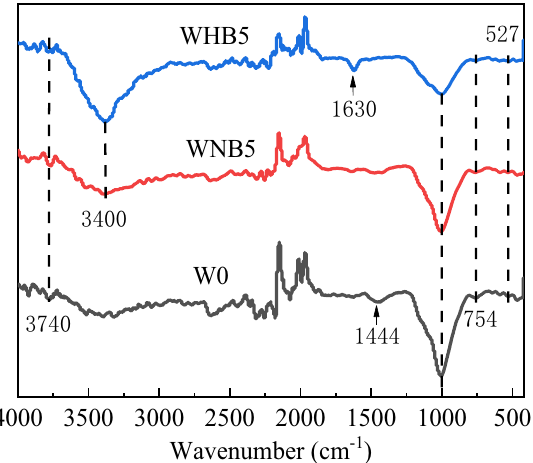
Fig. 12 FTIR spectra of unactivated and activated tailings powder